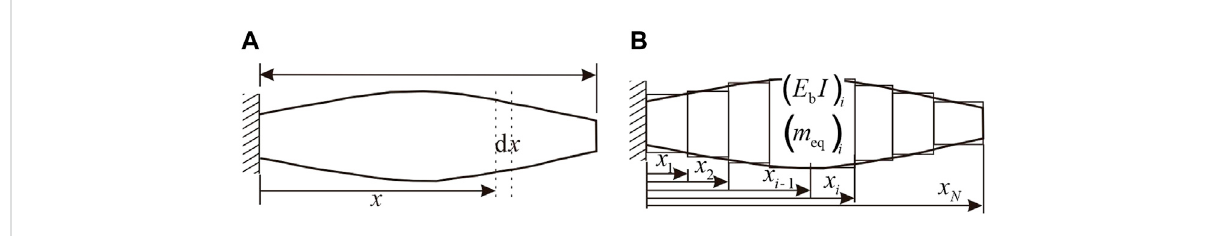
FIGURE 2 Sketch of the variable section cantilever beam. (A) Before segmentation; (B) after